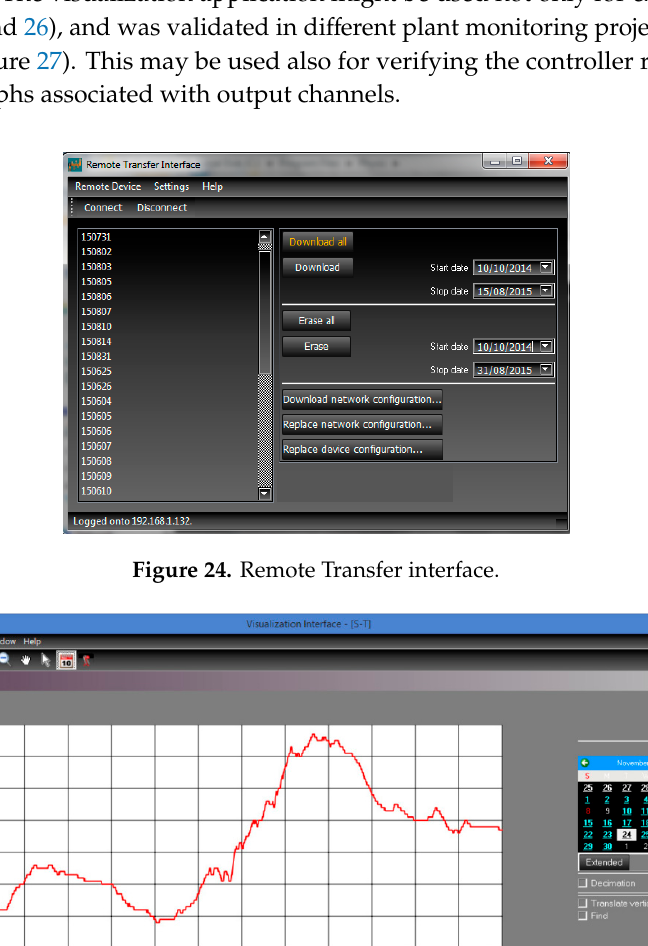
Figure 26. Rapeseed oil ( Brassica napus L.) plants subjected to water stress and overheating.